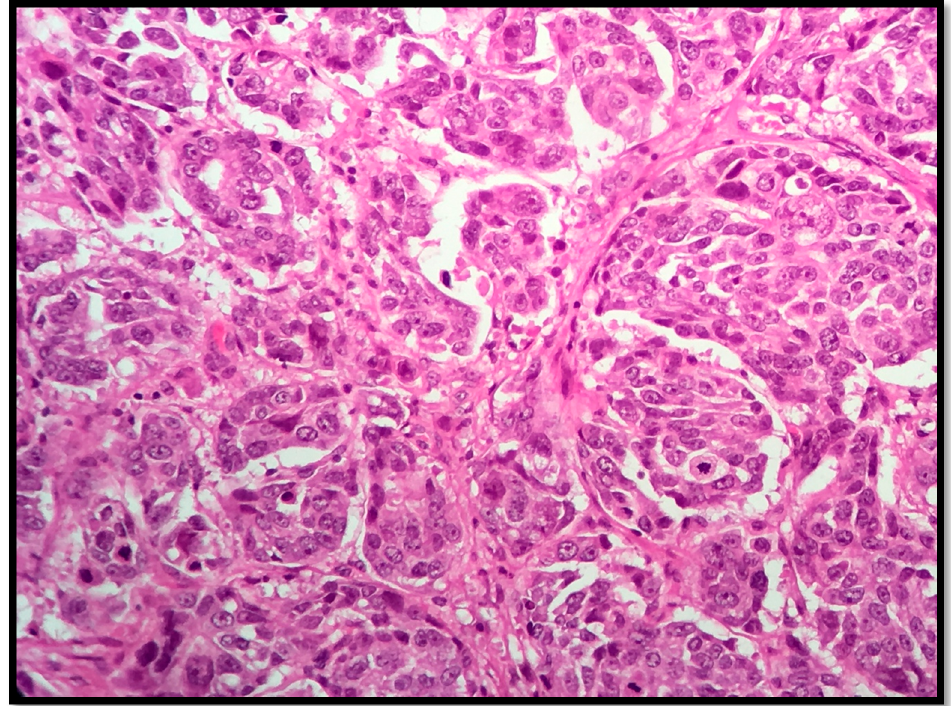
Figure 1. HE, 20 × NST (invasive ductal carcinoma), G2 (mitoses ‐ 2, tubule formation ‐ 2, nuclear pleomorphism ‐ 2).